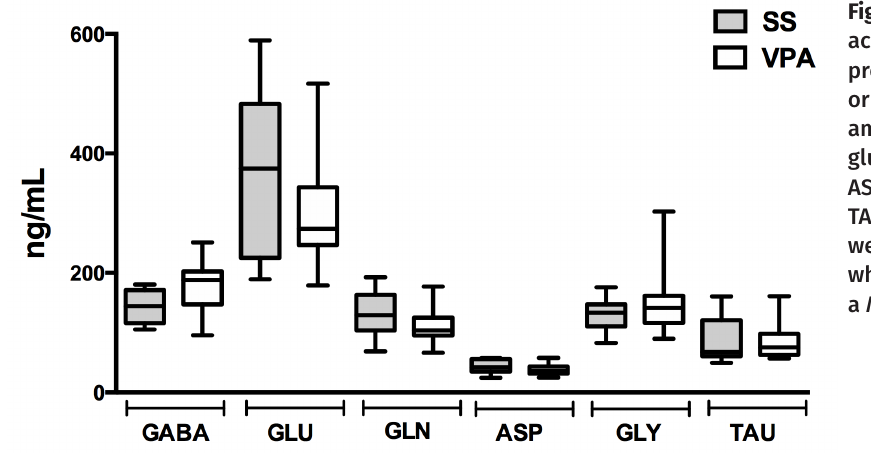
Figure 1. Brain plasma amino acid levels in infant rats prenatally exposed to VPA or Saline. GABA: